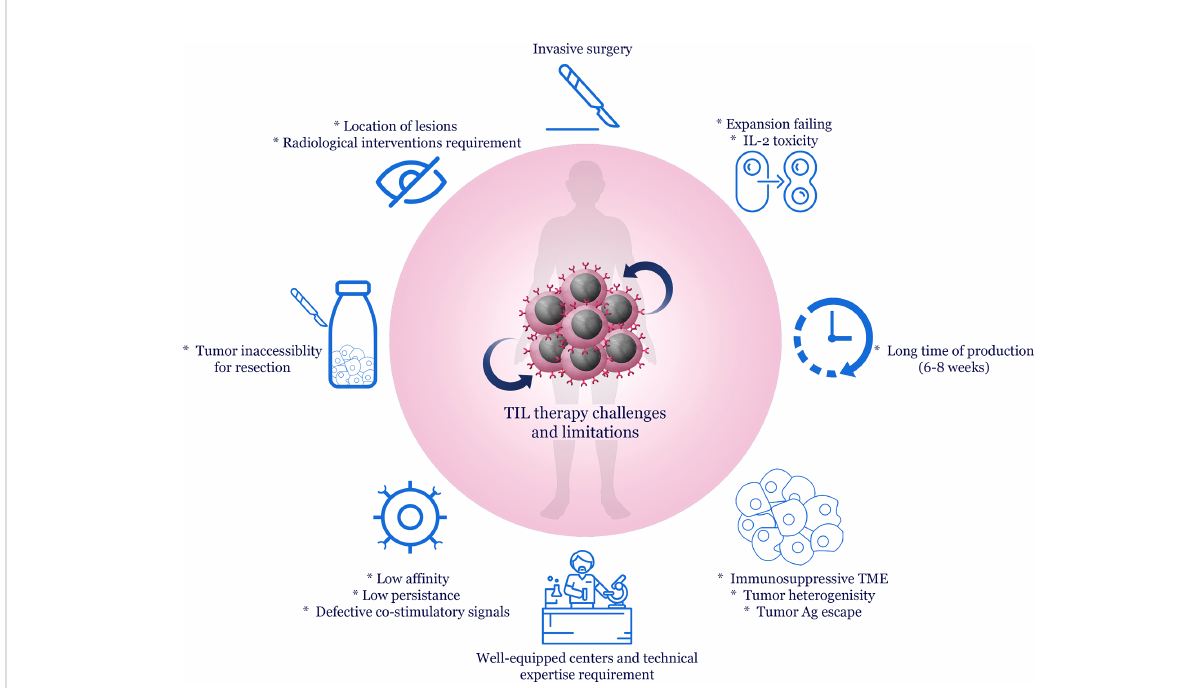
FIGURE 2 Challenges and limitations of TIL therapy. Immunosuppressive TME, tumor heterogeneity and immune system escape mechanisms are considered the main challenges to immunotherapy and cell therapy of human malignancies. Resection of the tumor mass may be dif fi cult due to the inaccessibility of the tumor tissue. Surgery is considered an invasive method for the patient. Moreover, expanding TILs requires appropriate equipment and technical experience after separating them from the tumor tissue. Despite these cases, in vitro expanding TILs sometimes fail, and high doses of IL-2 for expansion may also be associated with toxicity. On the other hand, the preparation time of TILs is about 6 to 8 weeks, which affects the effectiveness of treatment in highly progressive tumors. Additionally, the low af fi nity of TILs isolated from tumor tissue, low persistence, and defects in co-stimulator molecules are other problems with TIL